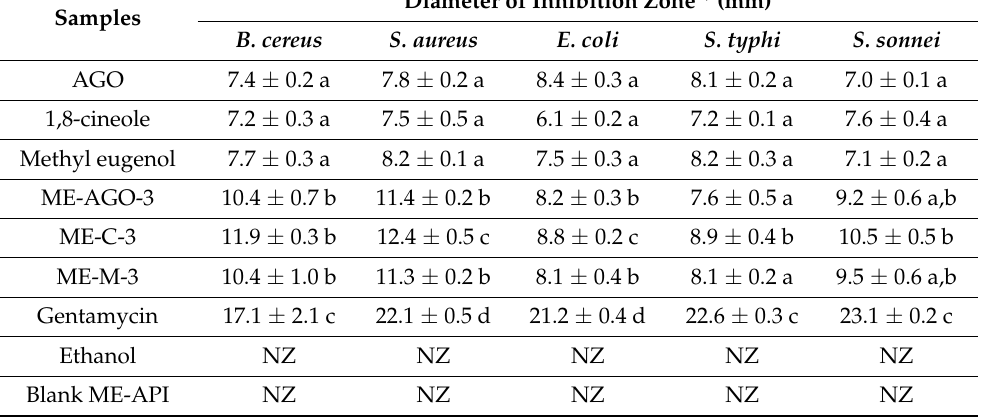
Table 2. Antibacterial activity of 30% w / w AGO in ethanol, 30% w / w 1,8-cineole in ethanol, 30% w / w methyl eugenol in ethanol, and their microemulsion (ME) formulation against selected foodborne pathogens ( n =